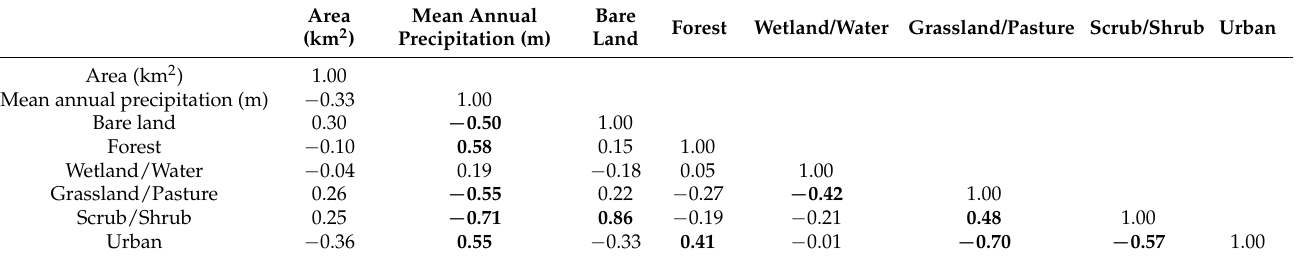
Table 4. Correlation (r) between catchment area (km 2 ), precipitation (m), and percentage of land cover (%).